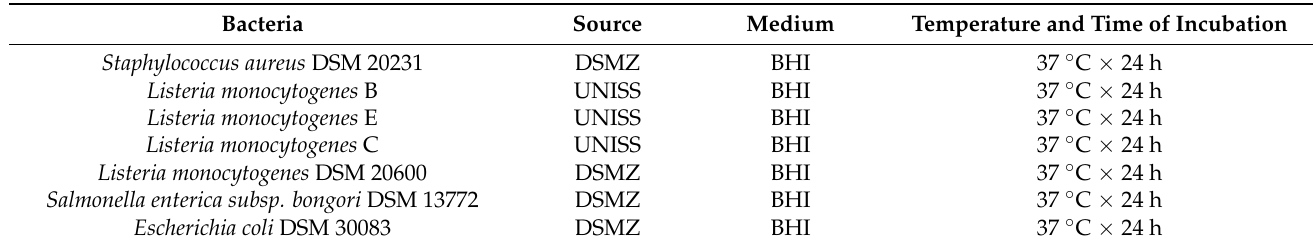
Table 1. List of microorganisms, medium, and culture conditions used in this work for testing the antimicrobial activity of diethyl ether extracts of saffron stamens (DES). Bacteria Source